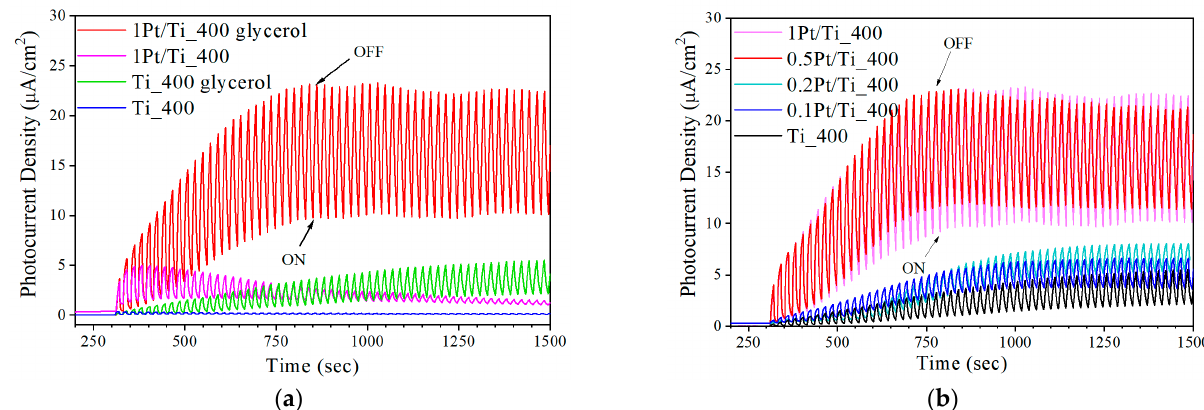
Figure 6. Transient photocurrent responses for pristine and Pt-doped TiO 2 in 0.1 M Na 2 SO 4 electro- lyte: the effect of ( a ) glycerol addition to the electrolyte and ( b ) Pt loading.